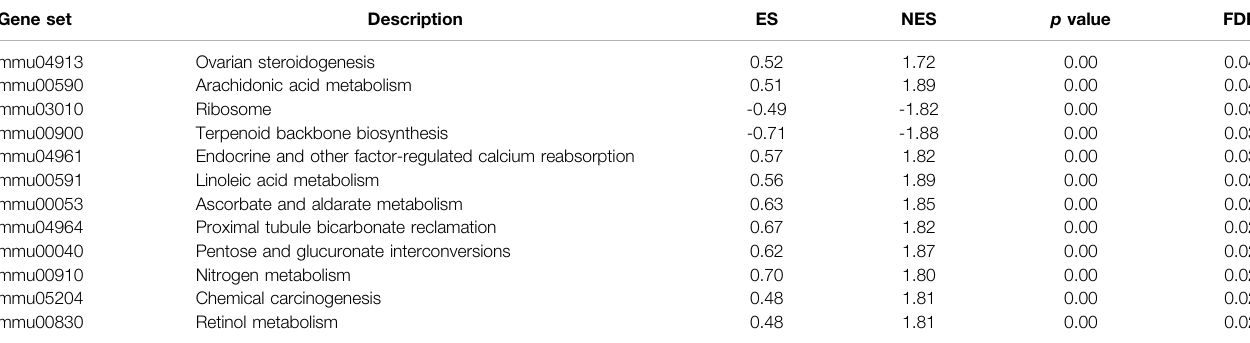
TABLE 3 | The full set of pathways identi fi